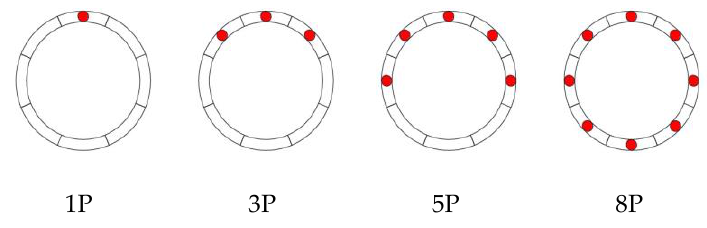
Table 4. Parameters of single-layer cylindrical reticulated shell.